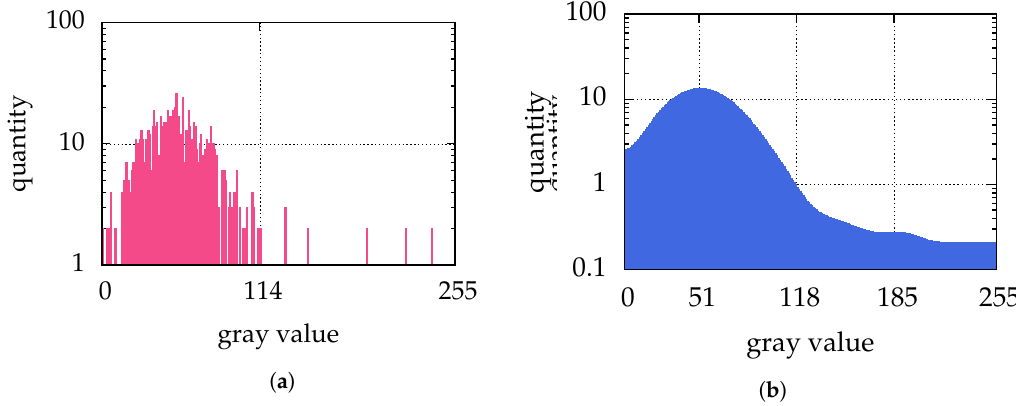
thresholding iteration applied to the histogram of Figure 2c. The Otsu’s method finds a threshold for binarization of 114 in Figure 2c. The intermodes thresholding smoothes the histogram of Figure 2c until there are the two local maxima 51 and 185, which leads to a threshold of 118. Because the image Figure 2c has no gray values between 115 and 119, there is no difference in the binarization of Otsu’s method and intermodes thresholding. Therefore, for both methods, the binarization of Figure 2c is shown in Figure